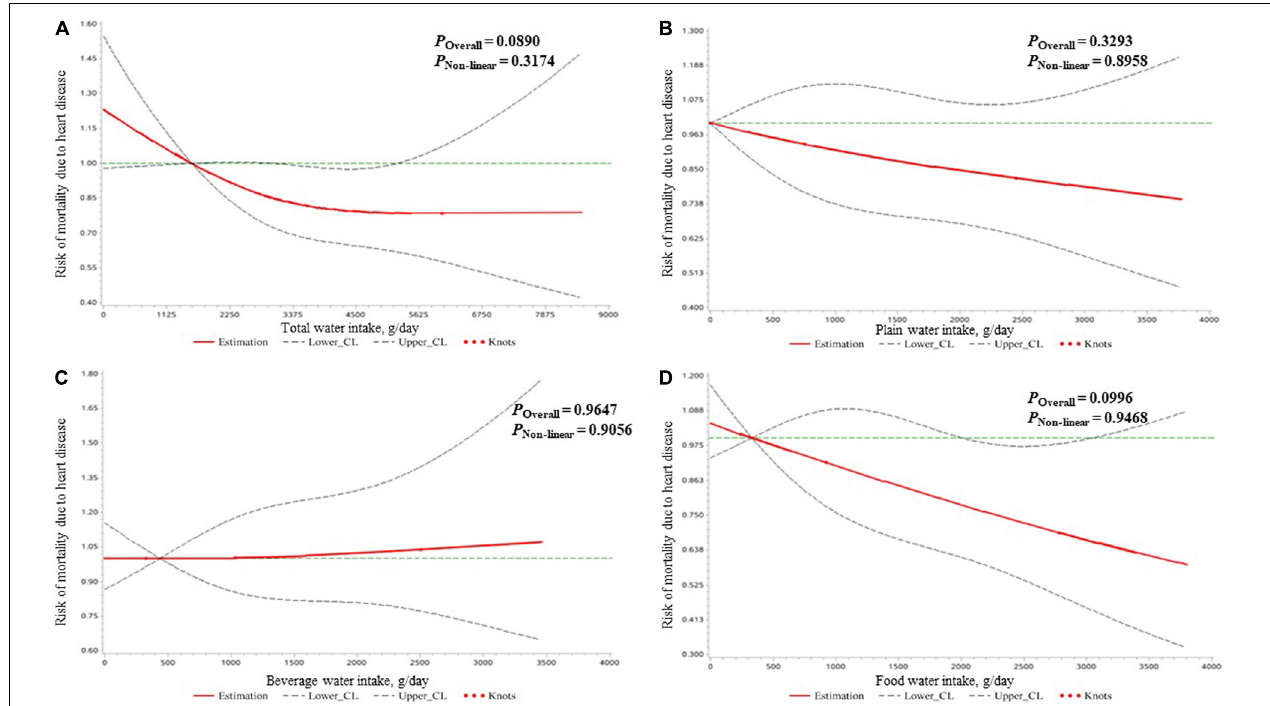
FIGURE 3 | The dose–response relationships of the amount of water intake [expressed by total water (A) , plain water (B) , beverage water (C) , and food water (D) ] with the mortality risk due to heart diseases in all participants clarified by restricted cubic spline